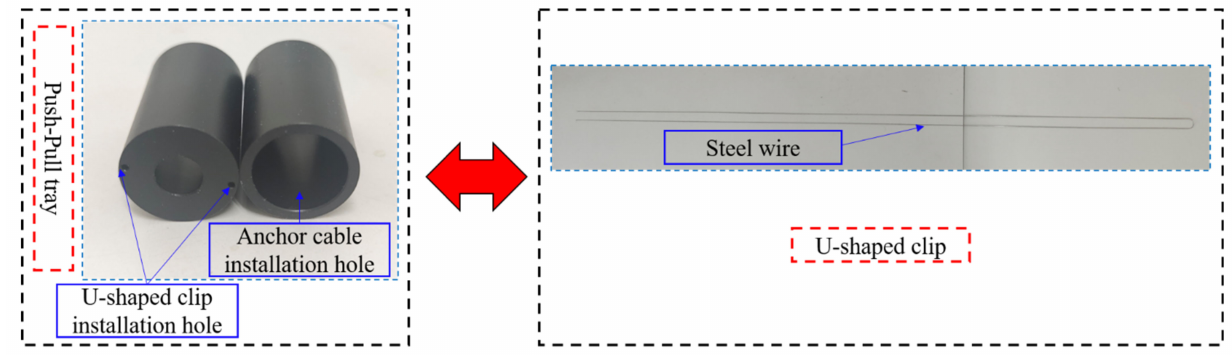
Figure 10. Schematic diagram of anchorage with push and pull equipment.